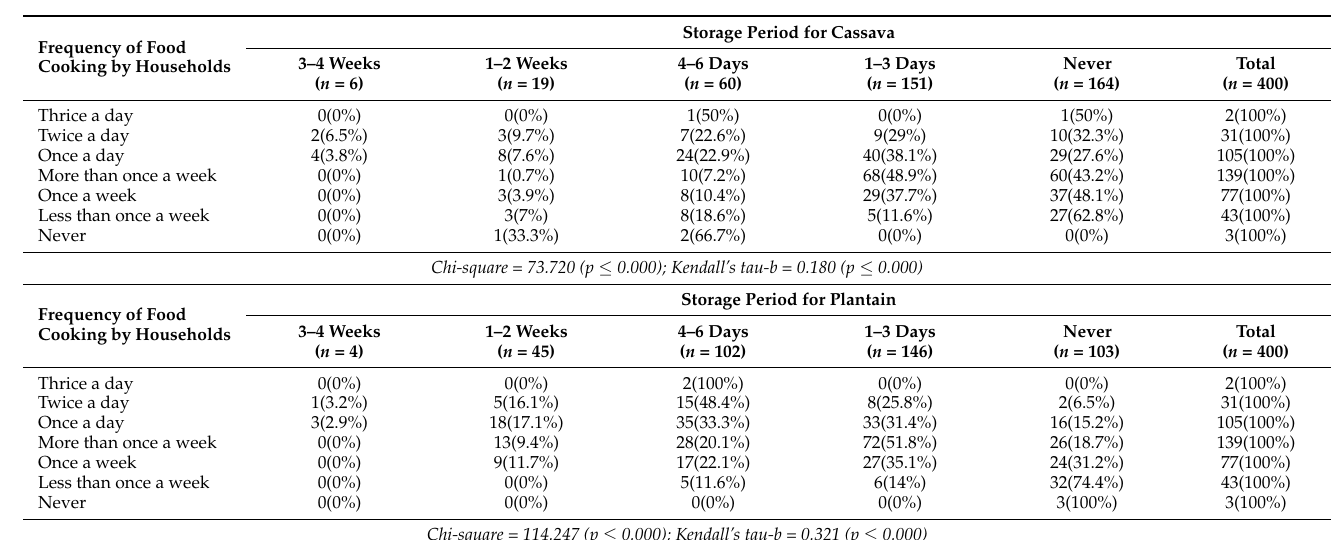
Table 5. Relationship between frequency of cooking at home and storage of cassava and plantain.